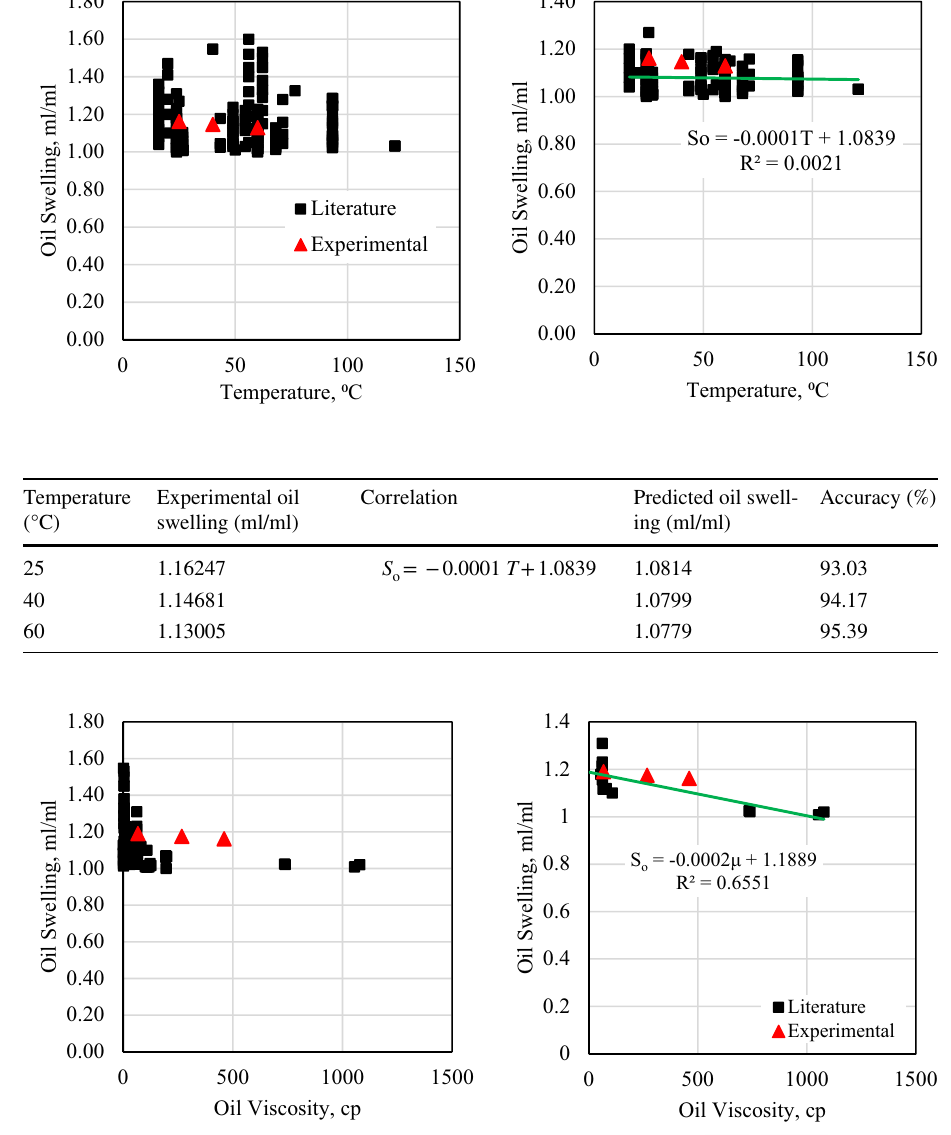
Fig. 7 Experimental and litera- ture oil swelling values at differ- ent temperature conditions